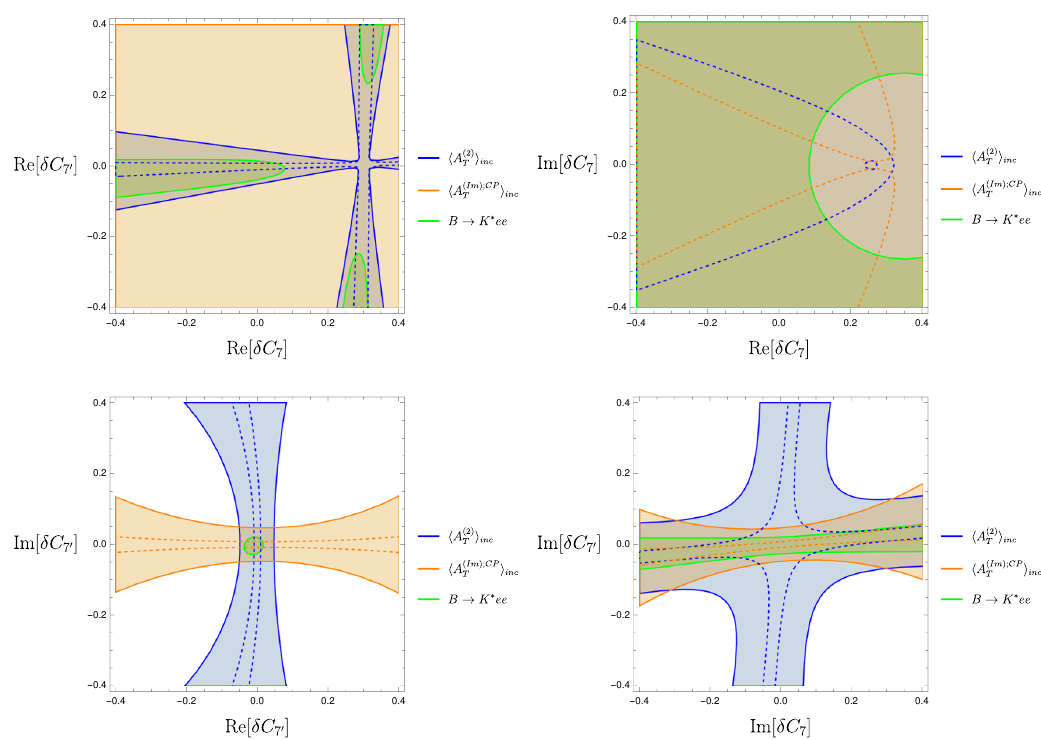
Figure 3 . Projected 1 σ contours on NP contributions to C 7 and C 7 0 from B s → φee observables at low q 2 : h A (2) i inc and h A ( Im ); CP i inc . Four NP scenarios are shown: (i) Re( C 7 ) vs. Re( C 7 0 ) , (ii) T T Re( C ) vs. Im( C ) , (iii) Re( C ) vs. Im( C ) and (iv) Im( C ) vs. Im( C ) . The SM point corresponds 7 7 7 0 7 0 7 7 0 to the origin (0,0). Meson mixing is taken into account for B observables. The dashed lines s → φee correspond to the future projections (300 fb − 1 ) for A (2) (blue) and A ( Im ); CP T T